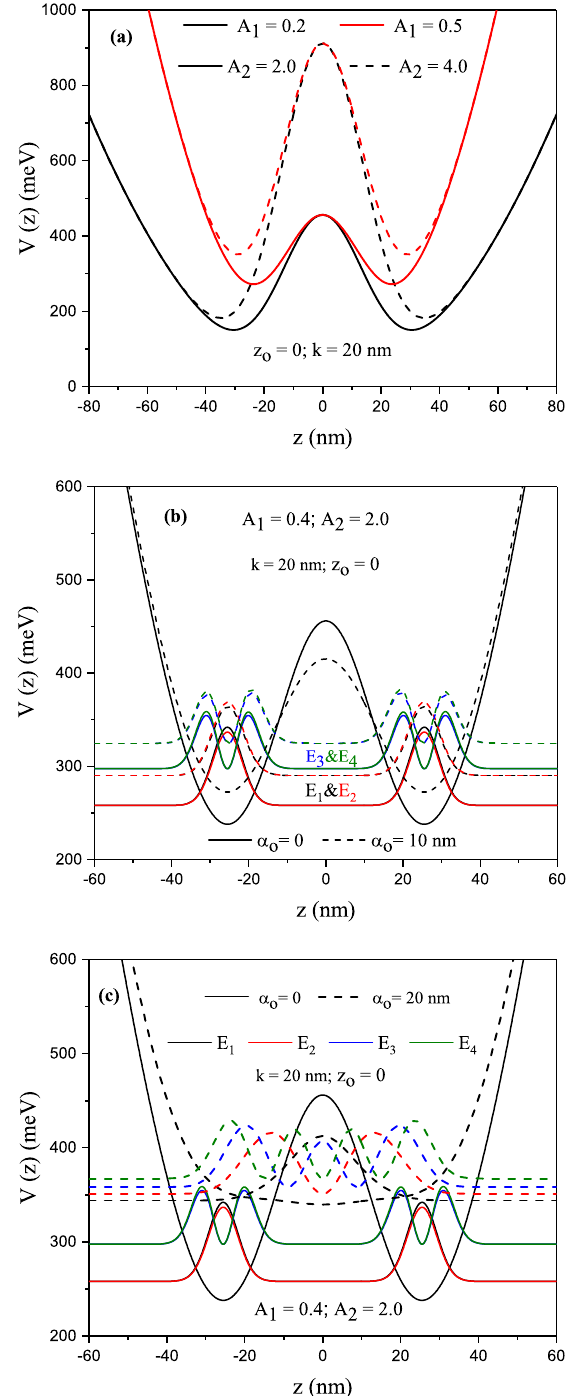
Figure 1. Parabolic–Gaussian symmetric DQW ( z o = 0) potential for a constant value of k (=20nm) versus the z -coordinate. Parabolic–Gaussian symmetric DQW, solid (dashed) curves are for A 2 = 2.0 ( A = 4.0 ) and black (red) curves A = 0.2 ( A = 0.5 ) ( a ), Parabolic–Gaussian symmetric 2 1 1 DQW confinement profiles and squared modulus of the wave-functions corresponding to the first 4 energy levels for α o = 0 (solid curves) and α o = 10nm (dashed curves) ( b ), and Parabolic–Gaussian symmetric DQW potential and squared modulus of the wave-functions corresponding to the first 4 energy levels for α o = 0 (solid curves) and α o = 20nm (dashed curves) ( c ). Results are for k = 20nm, A 1 = 0.4 and A 2 =